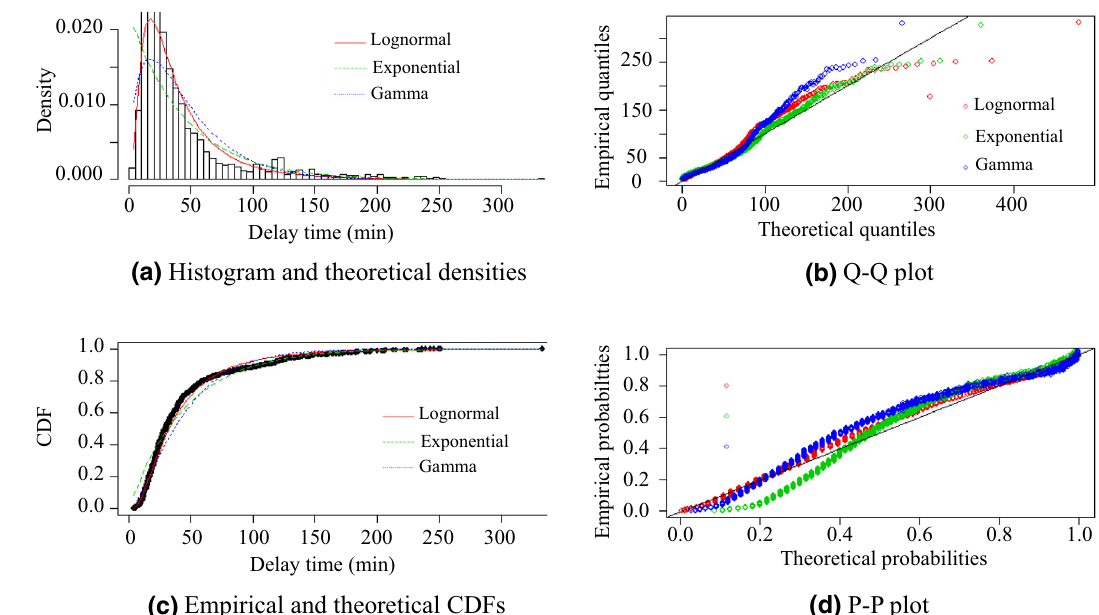
Fig. 6 Four types of plots for comparing the candidate distribution for BW. A density plot gives the shapes of the original and candidate distributions through a histogram; a CDF plot shows the fit of the cumulative distribution functions; a Q–Q plot and a P–P plot present the goodness of fit of the candidate distribution